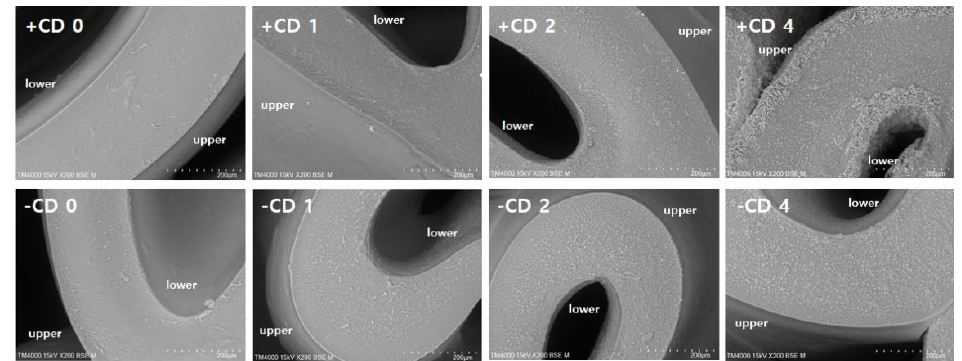
Figure 2. Scanning electron microscopy (SEM) images of transverse sections of ISP-based yuba films